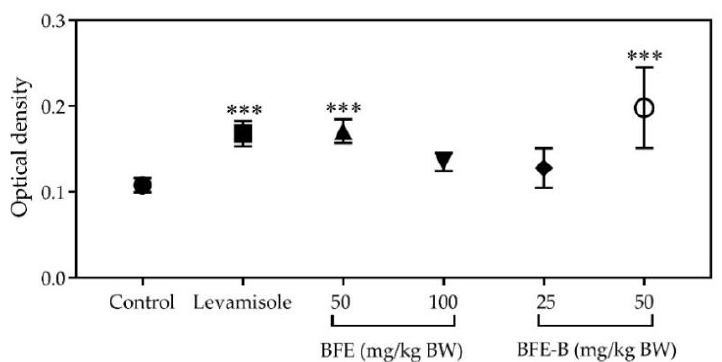
Figure 5. Effect of water-soluble fibers of P. erosus (BFE and BFE-B) on the proliferation of lymphocytes in mice induced with hepatitis B vaccine. Lymphocyte cells were cultured for 48 h. After cultivation, cell viability was measured by tetrazolium salt (MTT) cell proliferation assay and the absorbance was read at 550 nm. The data represent the mean ± SEM of five independent measurements. Significant differences compared with the control are determined at *** p < 0.001.